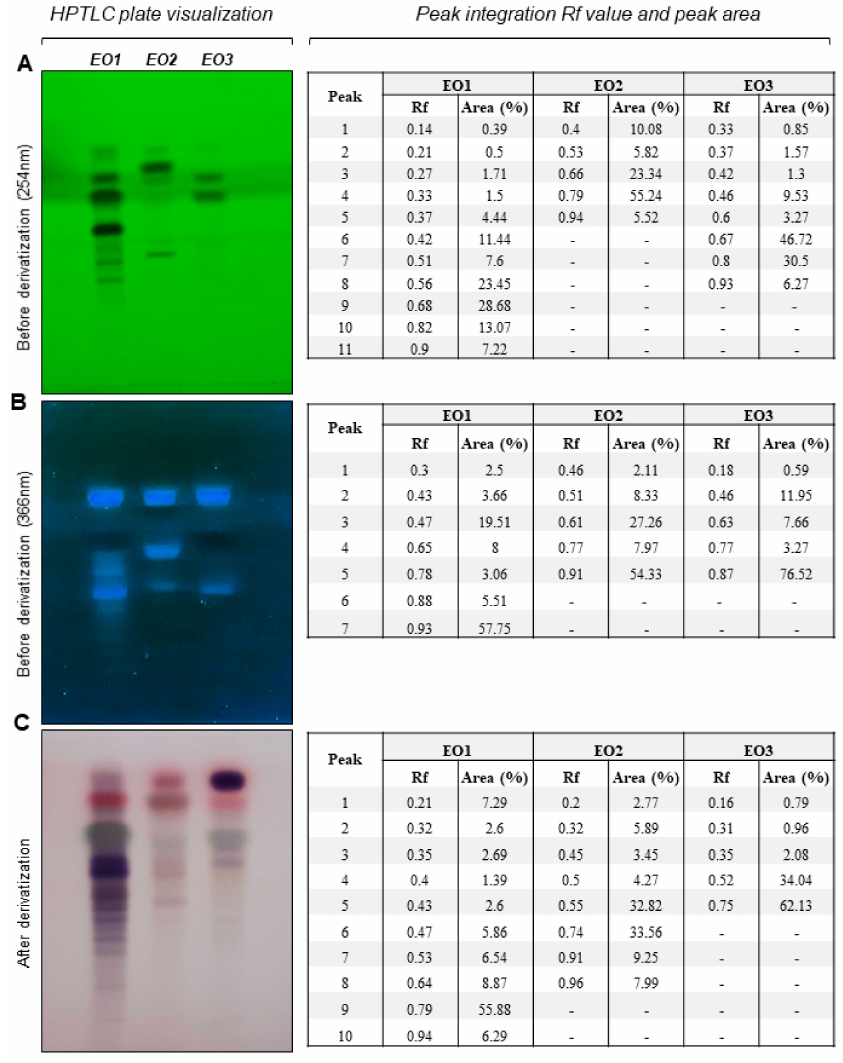
Figure 1. Developed HPTLC plate photograph of essential oil from O. gratissimum (EO1), O. tenuiflorum (EO2), and O. sanctum (EO3). ( A ) 254 nm before derivatization ( B ) 366 nm before derivatization ( C ) Visible mode after